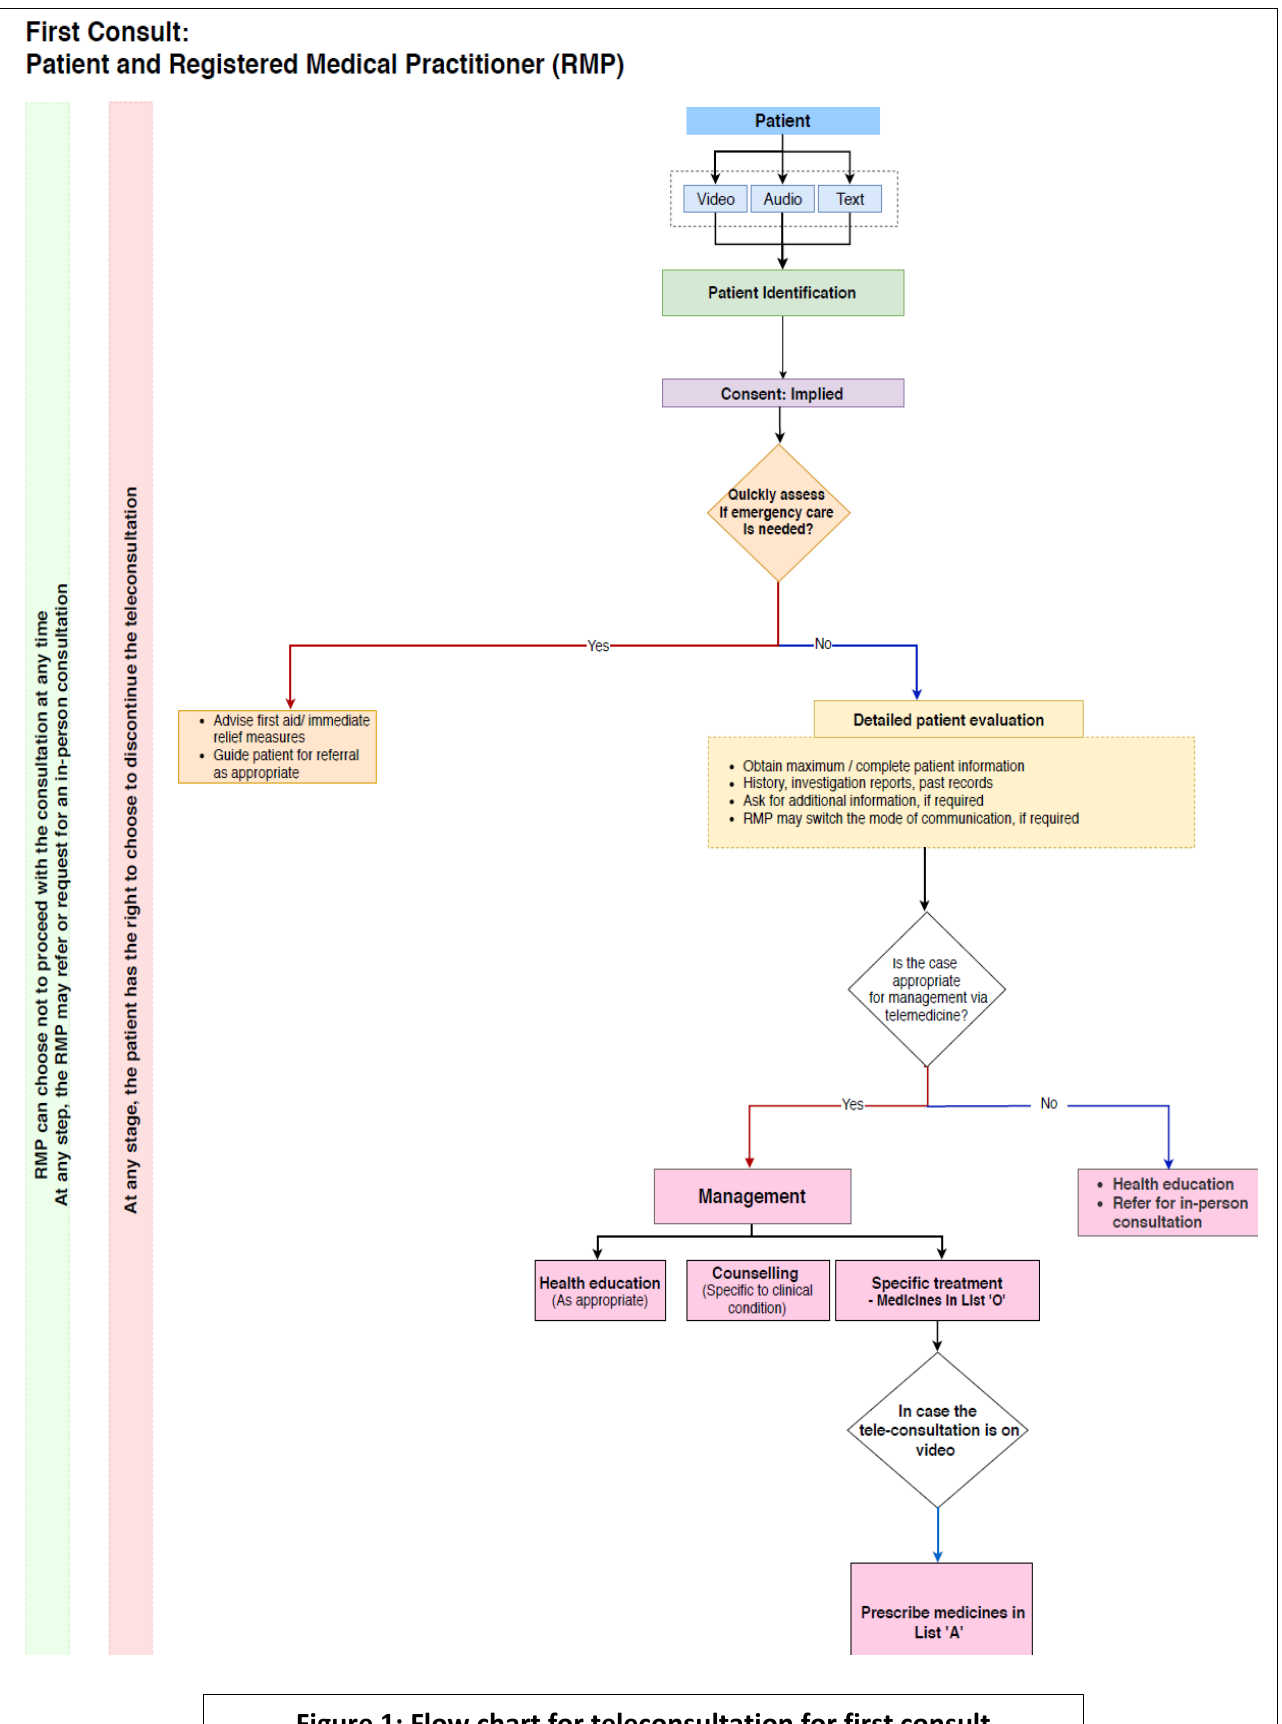
Figure 1: Flow chart for teleconsultation for first